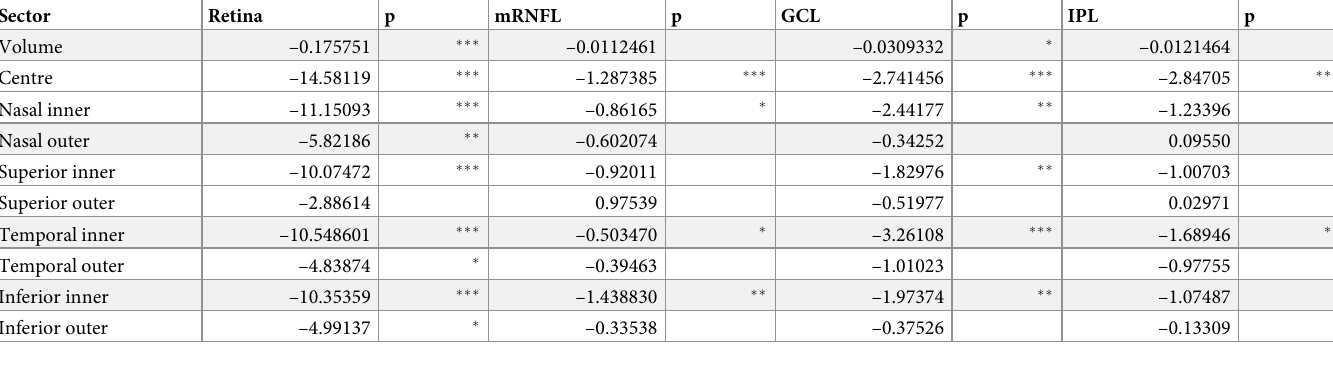
Table 3. Female regression coefficient in multivariate analysis controlling for age with macular sectorial thickness values as outcome.